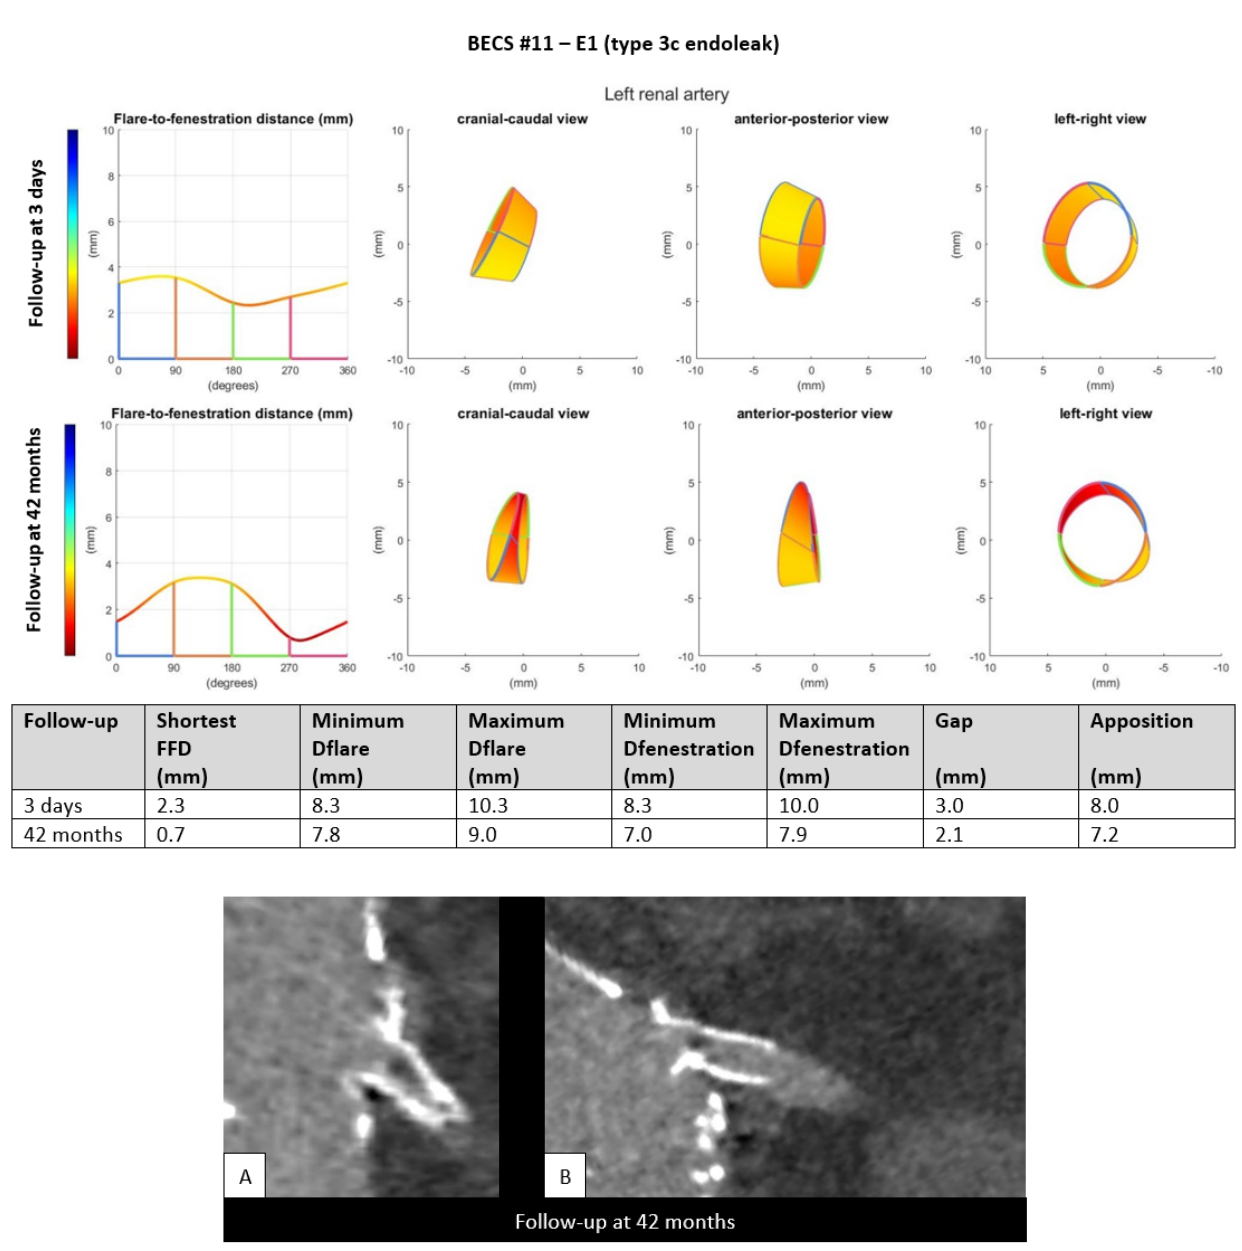
Figure 3. BECS #11 is an example of E1; endoleak due to insufficient flare distance. At the top, geometric analysis of 3-days and 42-months post-FEVAR CTA scans are shown. From left to right for both follow-up moments: circumferential FFD and cranial-caudal, anterior-posterior, and left-right view of the flare. At the bottom, ( A ) stretched vessel view of the aorta and ( B ) snake view of the left renal artery of the 42-months post-FEVAR CTA scan which showed the type 3c